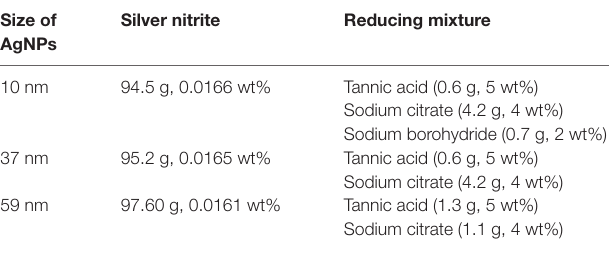
Table 2 | The amounts of reagents used for the syntheses of AgNPs. size of agnPs